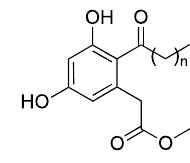
Figure 5. Piericidin A, a natural product T3SS inhibitor isolated from Streptomyces sp. 16–22 [50].